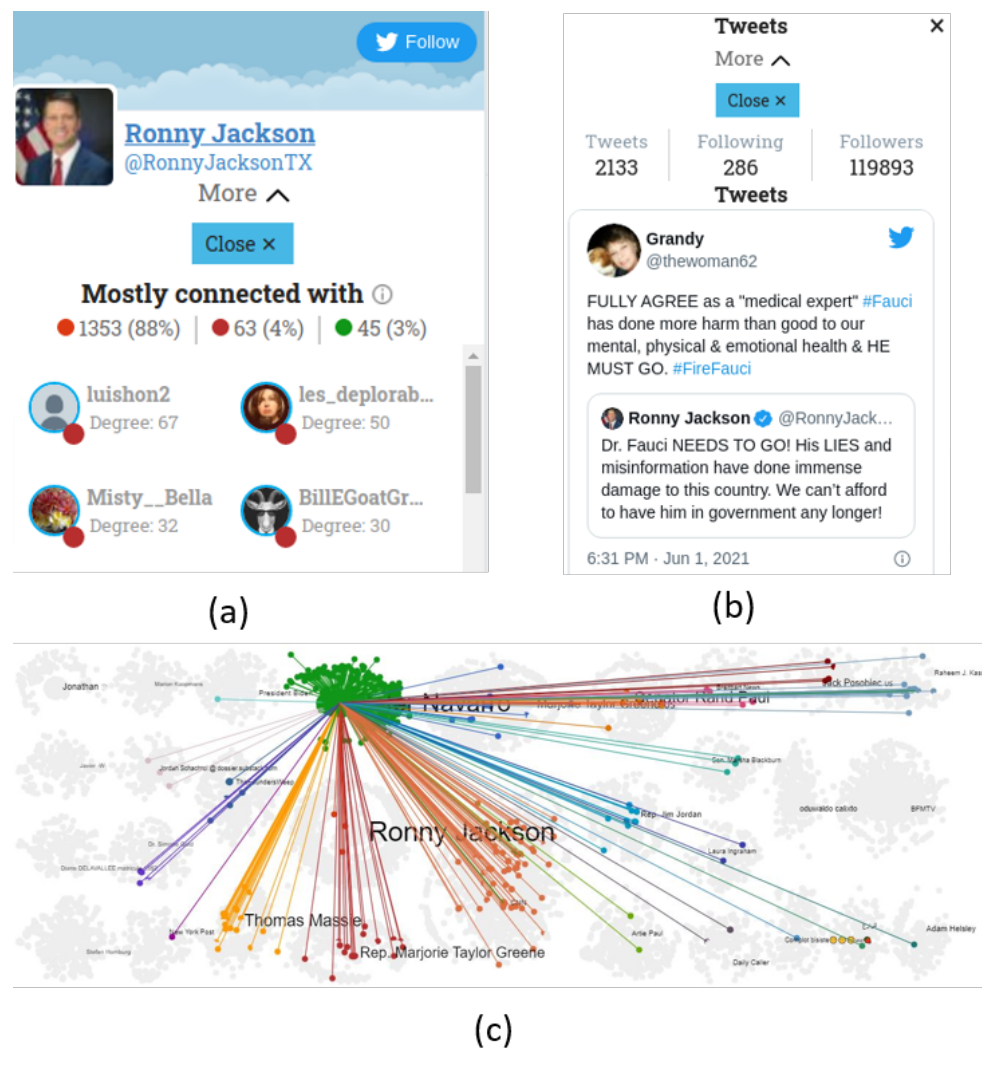
Figure 2. Individual user inspection. ( a ) Information about the user, ( b ) text of the tweets made by the user and ( c ) the interactions of this